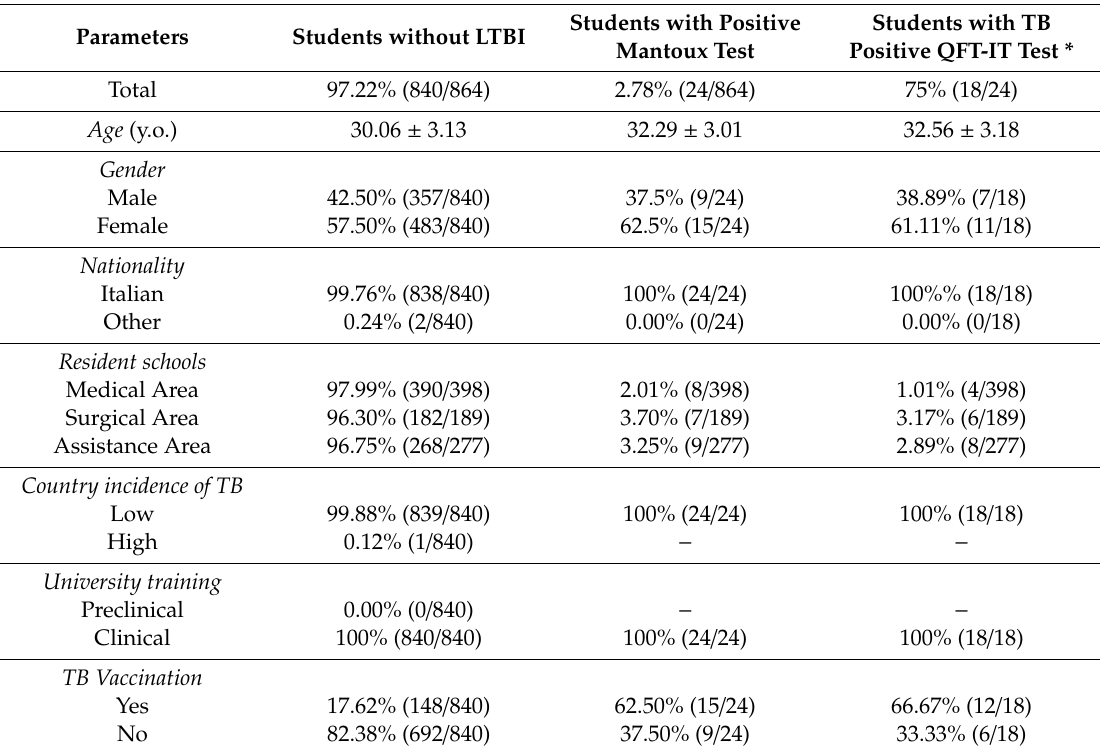
Table 2. Characteristics of 864 postgraduate medical students (PMS) participants, stratified into postgraduate medical students with and without latent tuberculosis